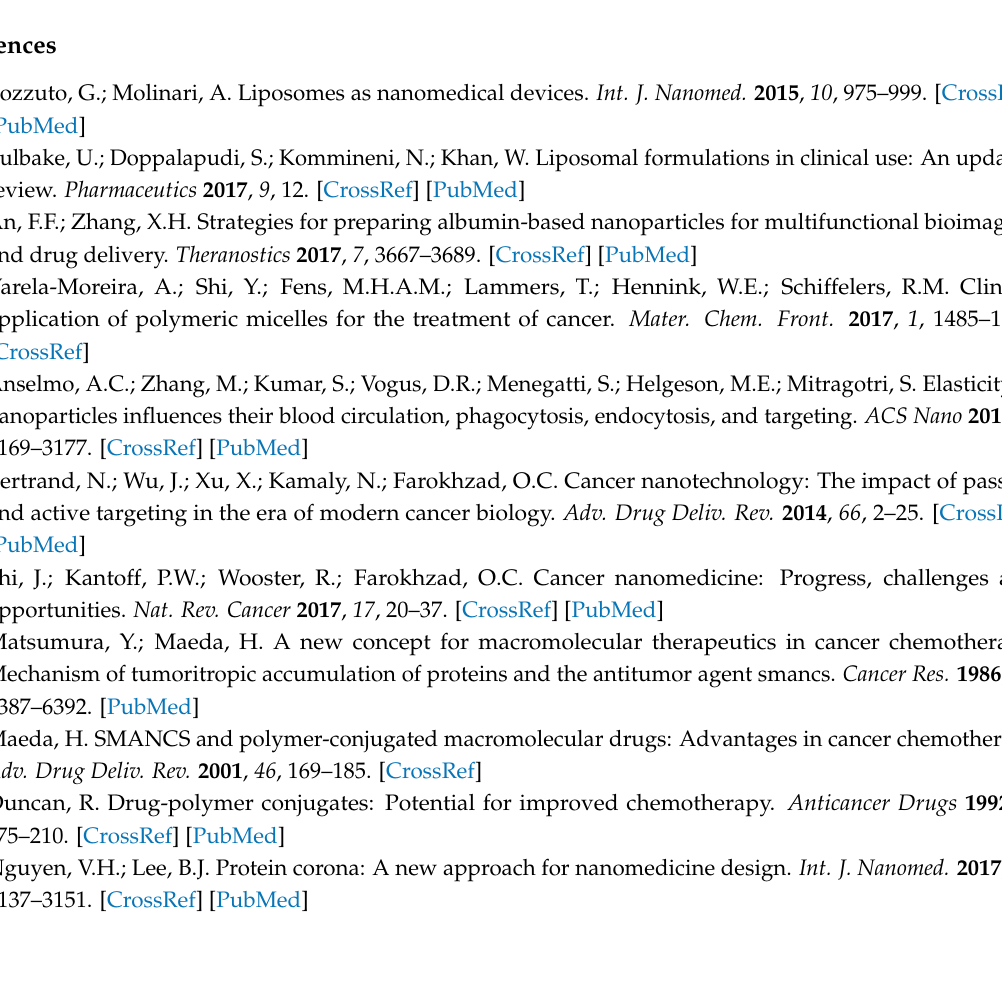
DiI peak absorbance